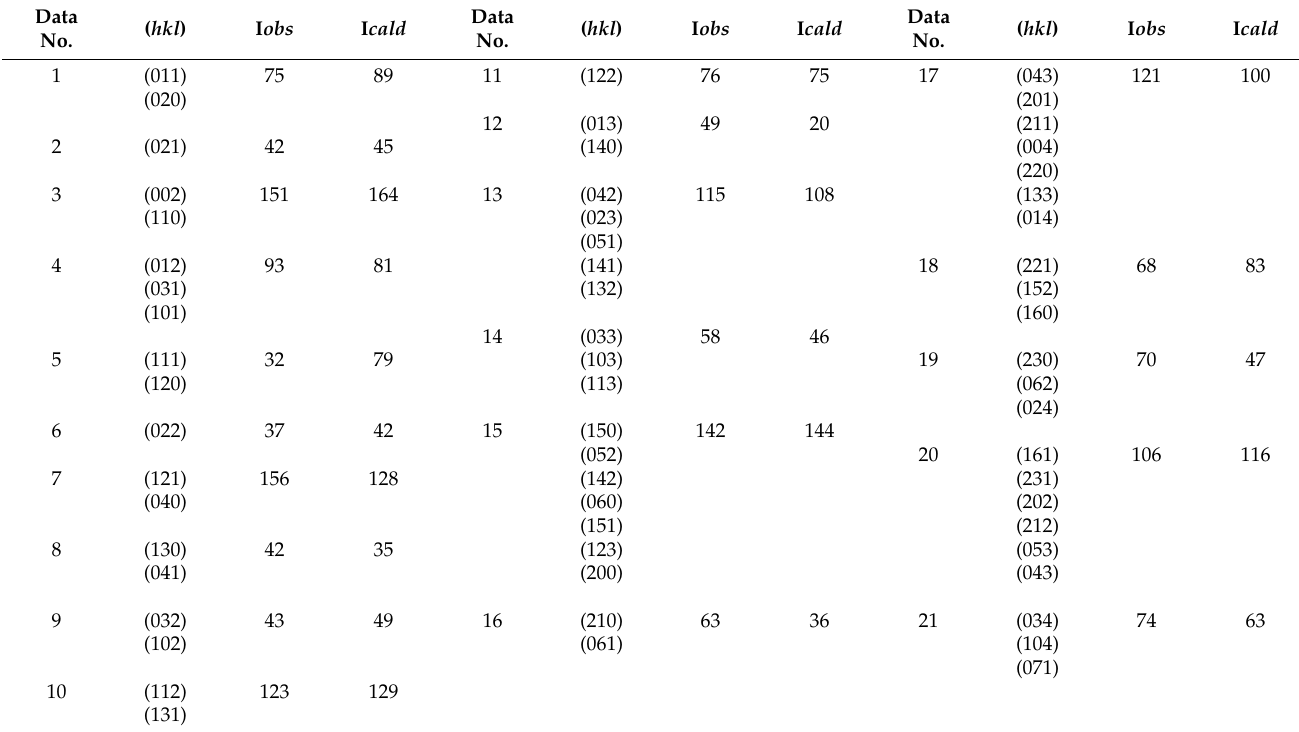
Table 1. Observed (I obs ) and calculated (I cald ) structure amplitudes for type II β -turn as the model of silk I [22,48,74]. Reprinted with permission from ref. 22. Modified from ref. 22. Data